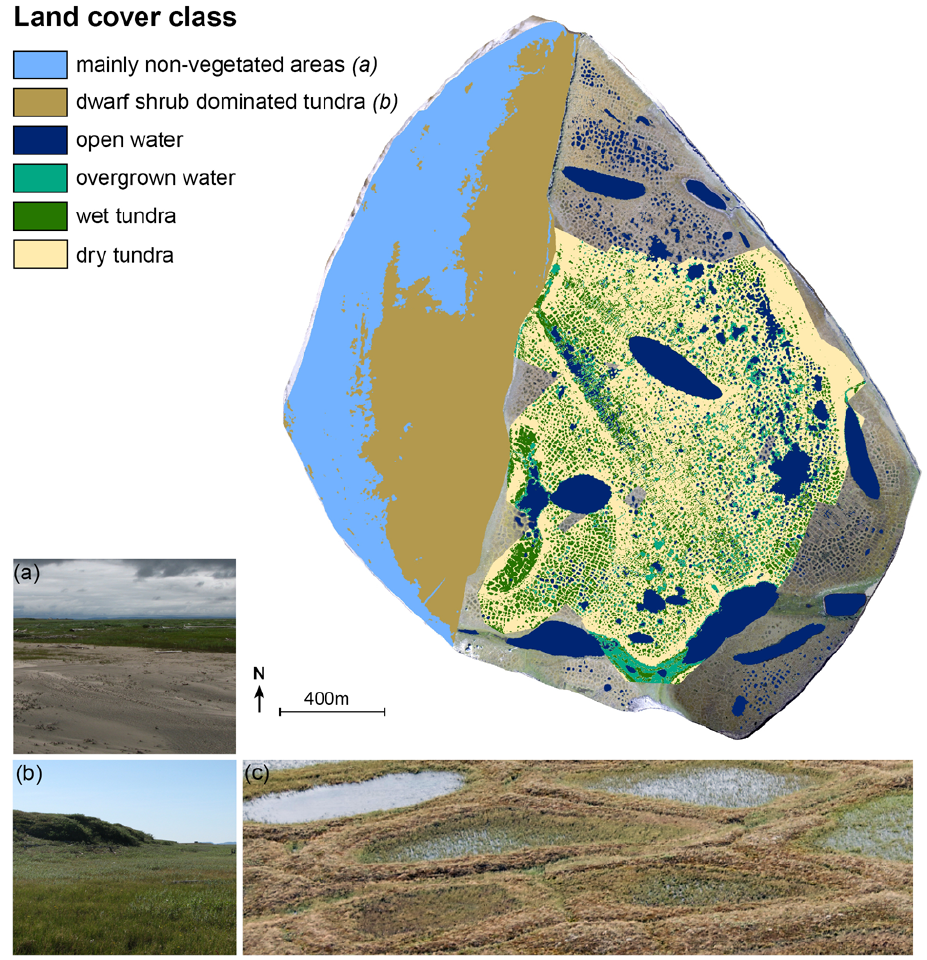
Fig. 3. Land cover classes on Samoylov Island. Classification of the eastern part of the island is based on Muster et al. (2012). The western part, which is non-vegetated or dwarf shrub tundra, is subject to flooding by the Lena River during spring. Overgrown water and wet and dry tundra were only classified for a subset of the terrace. The classification is overlain on the 2007 VIS orthophoto (grey